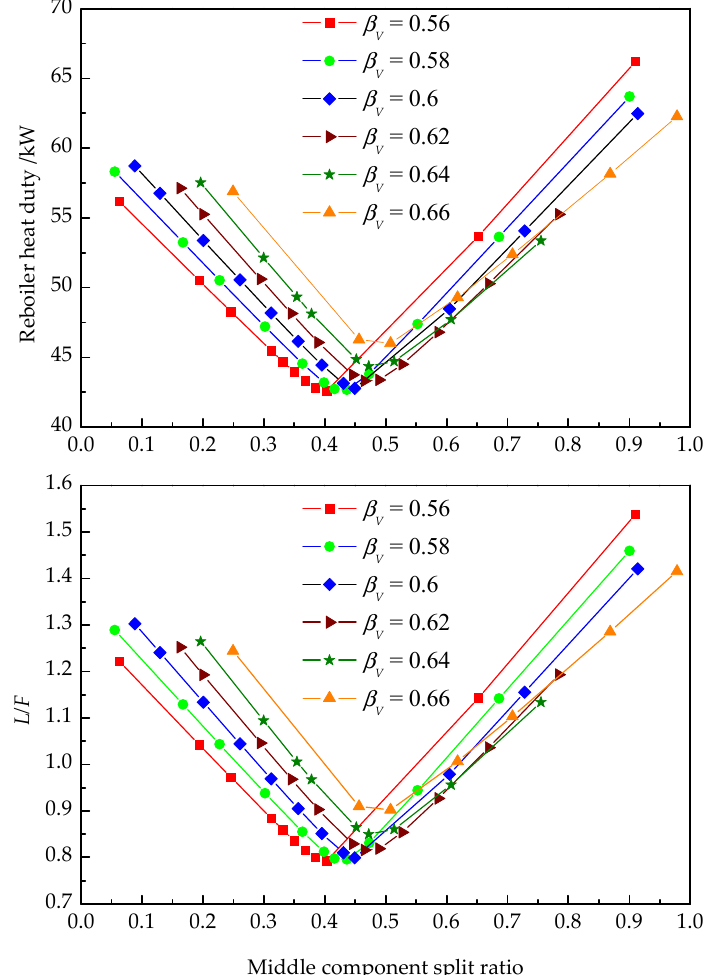
Figure 10. The middle component split ratio at the top of pre-fractionator versus corresponding L / F and the heat duty of